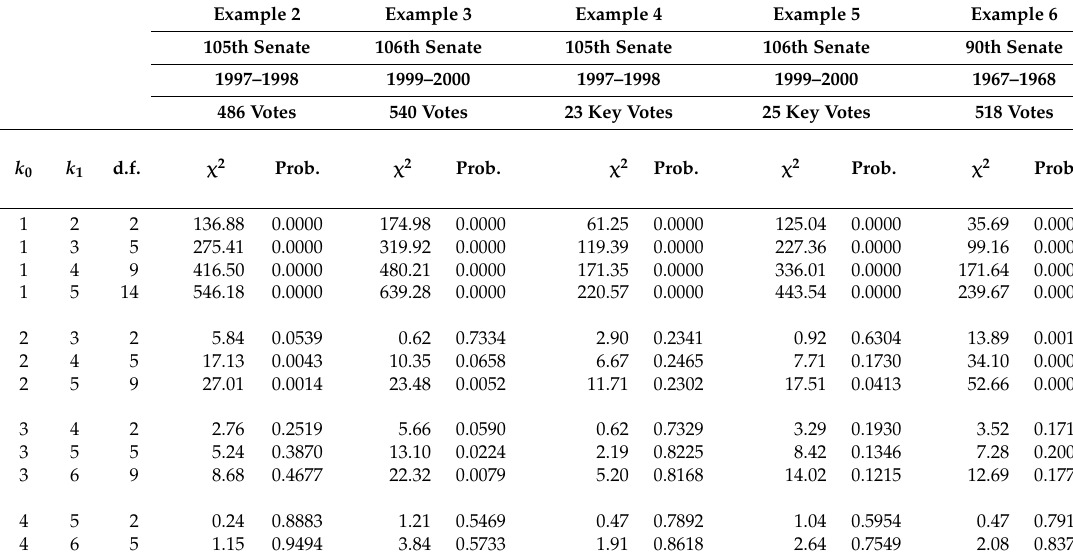
Table 4. Chi-square values from (4) along with their upper-tail probabilities, for Examples 2-6, for certain ( k 0 , k 1 ) and corresponding degrees of freedom. Example 2 Example 3 Example 4 Example